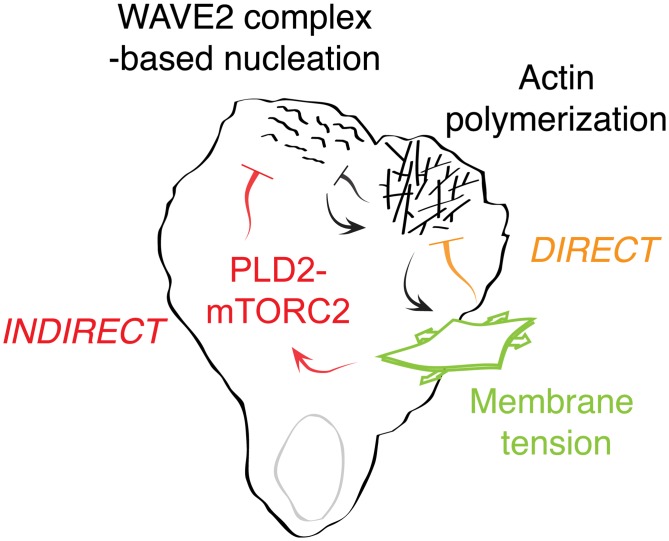
Working model of PLD2–TORC2 membrane tension negative feedback loop.Actin assembly increases membrane tension, which activates two inhibitory links to actin network growth. In the first link, membrane tension directly inhibits actin polymerization by acting as a physical barrier to growth. In the second link, membrane tension acts through the PLD2–mTORC2 pathway to inhibit actin nucleation via the WAVE2 complex. This circuit forms a mechanosensory negative feedback loop that regulates membrane tension and controls the spatial organization of actin assembly during neutrophil polarity and movement.